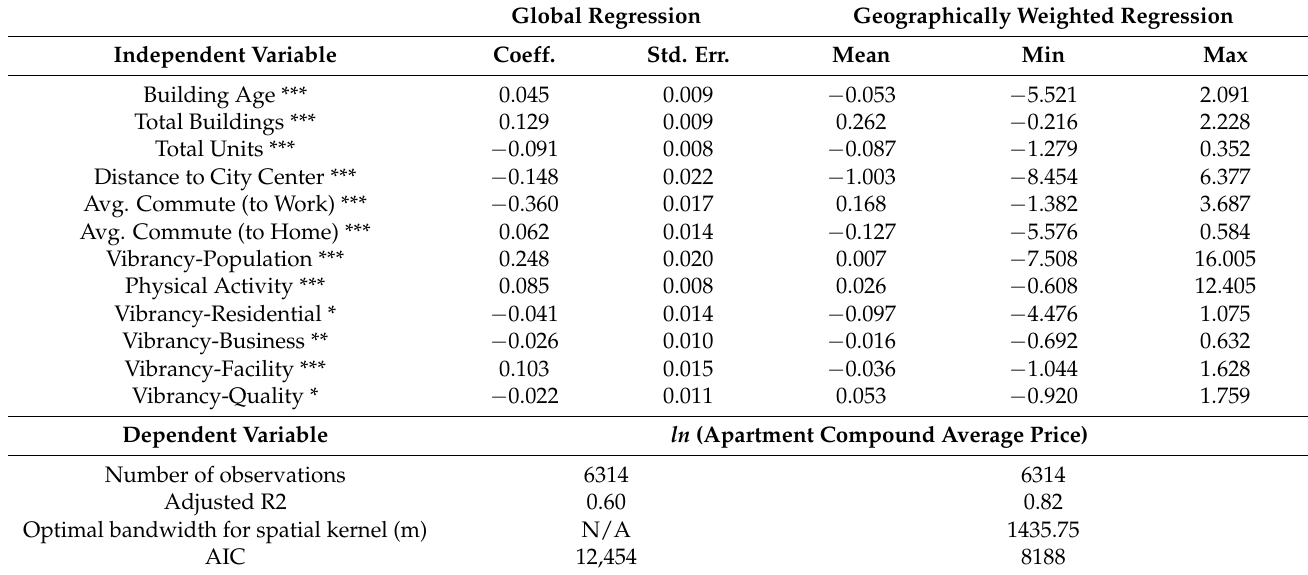
Table 4. Results from a global regression and GWR model of real estate price. Global Regression